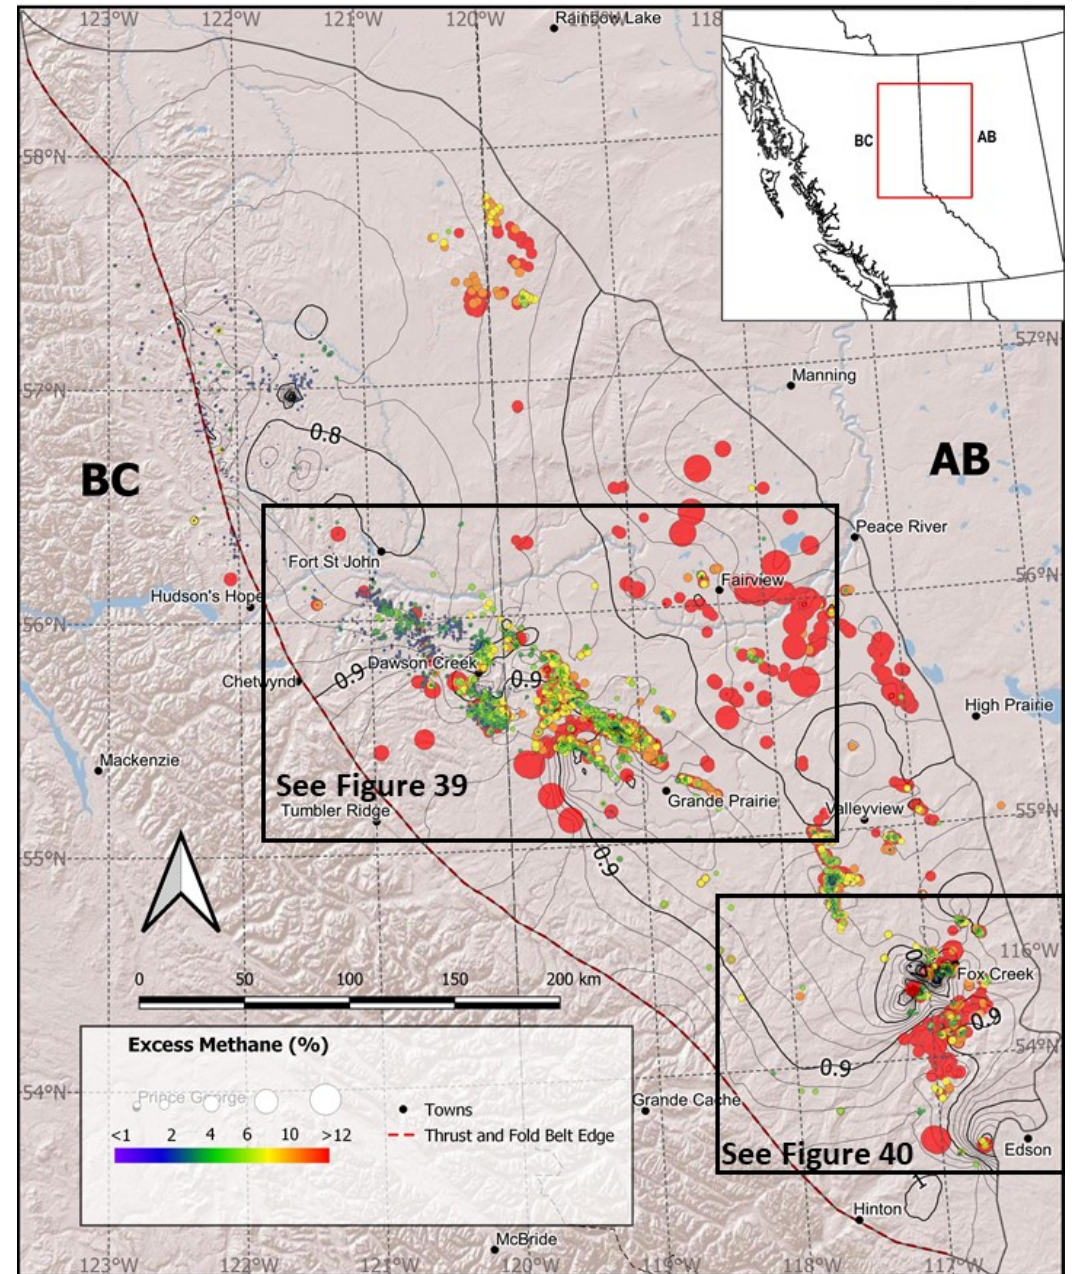
Figure 38. The excess methane percentage (symbols) for Montney Producers in BC and Alberta. The excess methane percentage is the calculated increase percentage of methane based on the iC4/nC4 ratio regional maturation trend of [4]. The methane gas dryness percentage is also shown as contour lines. The contour interval is 0.025 (i.e., 2.5%). Darker colours are indicative of hydrocarbon compositions that are aligned with the regional maturation trends across the basin and probably self-sourced hydrocarbons or very limited migration distances. The larger orange and red symbols indicate locations that have the hydrocarbon composition not aligned with regional maturation trends, and there is a larger component of migrated hydrocarbons in the reservoir. This is well illustrated by the Montney in eastern Alberta that is a more conventional petroleum system.